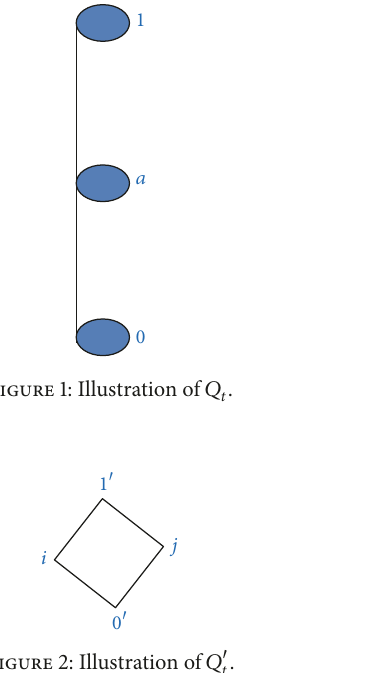
Table 1: Binary operation ∗ 1 subject to 𝑄 𝑡 .